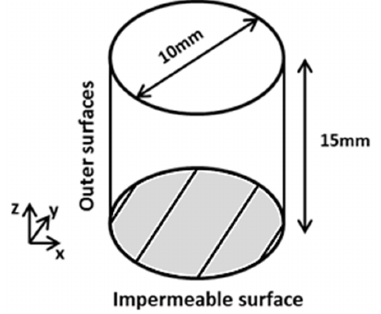
Figure 5. Description of three-dimensional geometry used for finite-elements method (FEM) simulation with boundary conditions.